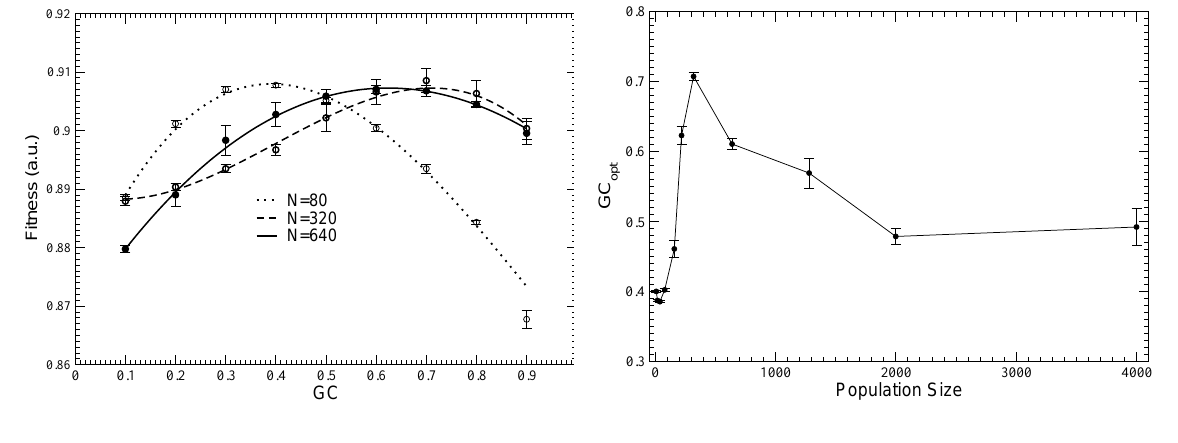
Figure 6. ( Left ) For fixed population size, fitness, and, hence, protein stability, attains a maximum as a function of mutation bias, measured as the GC content that would be attained under mutation alone. The three curves have been vertically shifted to make the intra-curve comparison clearer. ( Right ) This optimal mutation bias, GC , depends on the population opt size; it favors AT for a small population size, GC for intermediate population size and the absence of bias (GC = 0 . 5 ) for a very large population size. Reproduced from [79], copyright of the